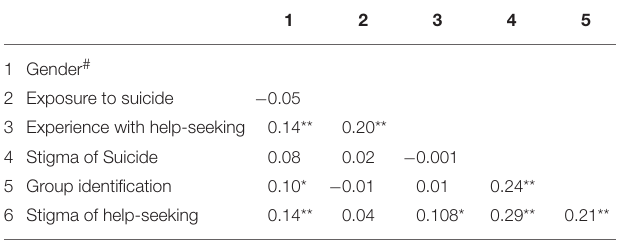
TABLE 1 | Pearson’s correlation coefficients for study